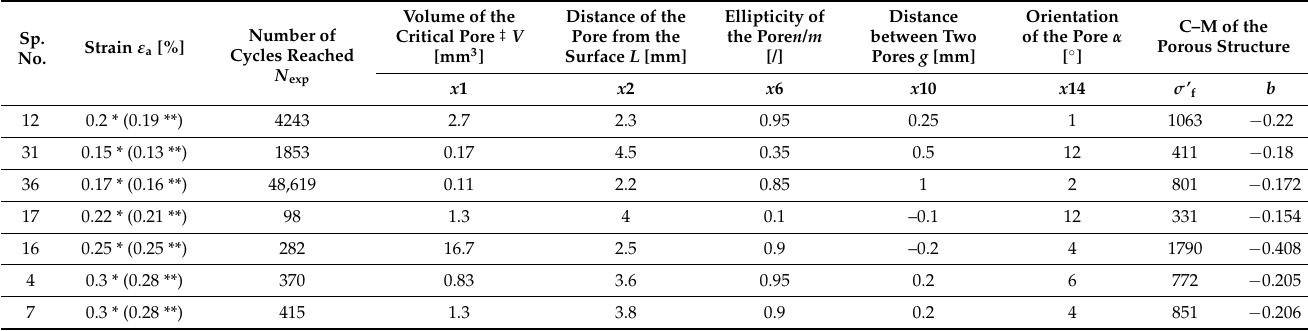
Figure 5. Shift of the Coffin–Manson ε a – N durability curve due to the presence of individual geometric porosity influencing factors. Table 1. Geometric characteristics of the critical pores and the fatigue life of the tested